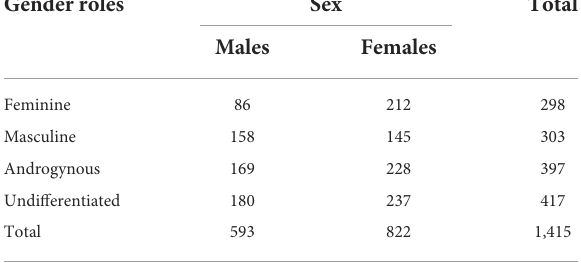
( p = 0.002) and the masculine gender role was not significantly different from the other gender roles. When we considered the nonassertive reactions, the feminine category reported lower scores compared to the androgynous ( p = 0.017) and the masculine ( p = 0.004) gender role categories; moreover, the masculine category reported higher scores when compared to the undifferentiated category ( p = 0.029); this latter category reported lower scores when compared to the androgynous category ( p = 0.006). When we compared sex, women reported higher scores for both types of reactions ( F (1 ; 1,331) = 5.68, p < 0.05, partial η p 2 = 0.004; F (1 ; 1,331) = 101.33, p < 0.001, partial η p 2 = 0.071,